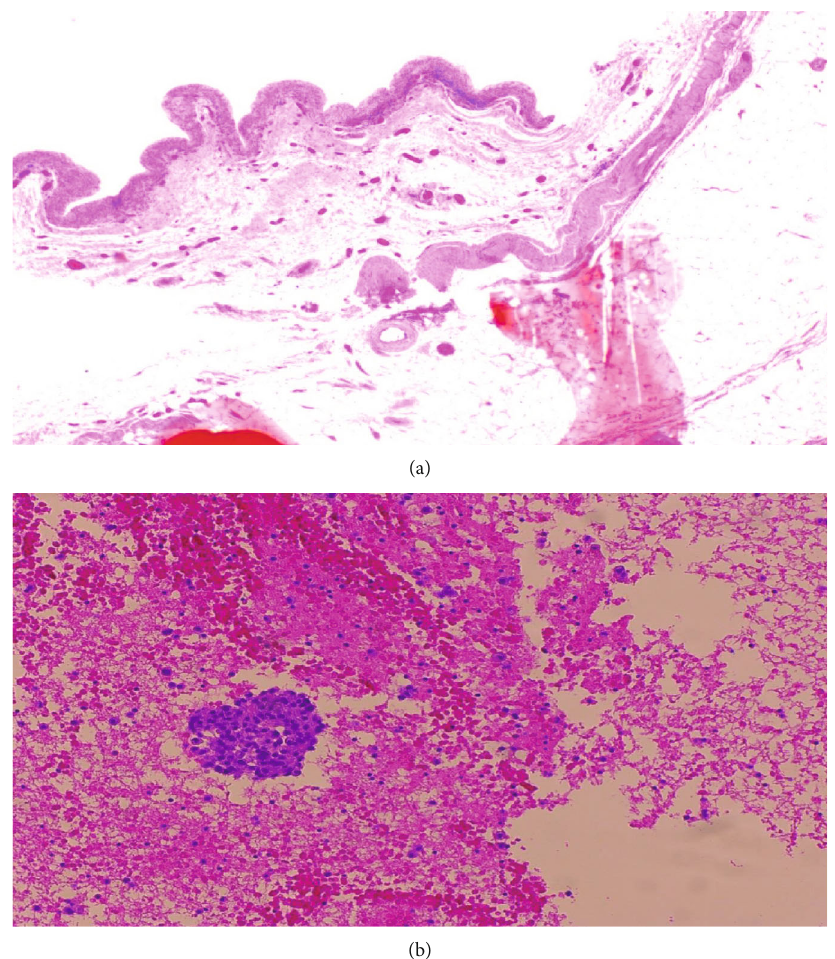
Figure 4: (a, b) Reresection of the right breast peri-implant capsule with exudate, microscopic appearance. Marked synovial metaplasia of the capsule and focal in fi ltration by small lymphocytes. No evidence of residual